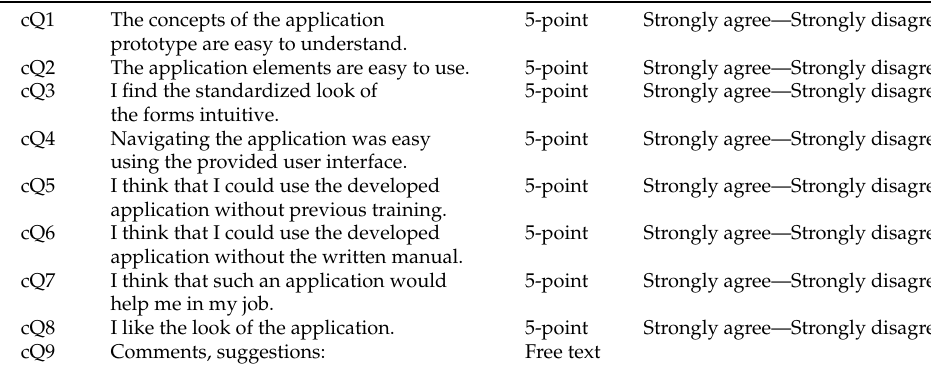
Table 4. Developed application prototype evaluation